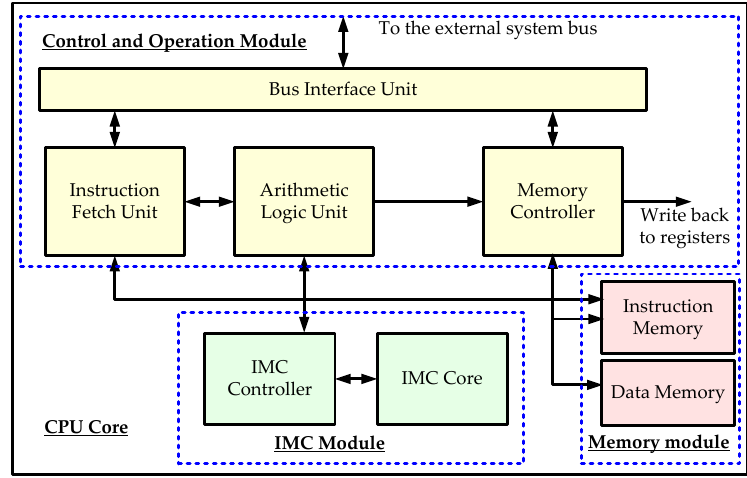
Figure 2. Modified RISC-V processor core with in-memory computing (IMC).